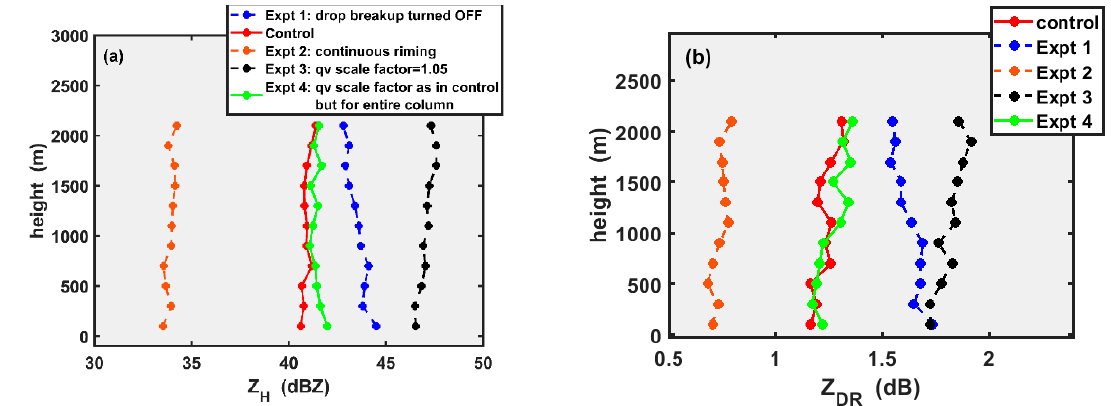
Figure 10. Height profiles of forward modeled ( a ) Z H and ( b ) Z DR using the control and McSnow DSDs in experiment 1–4 in the different layers.